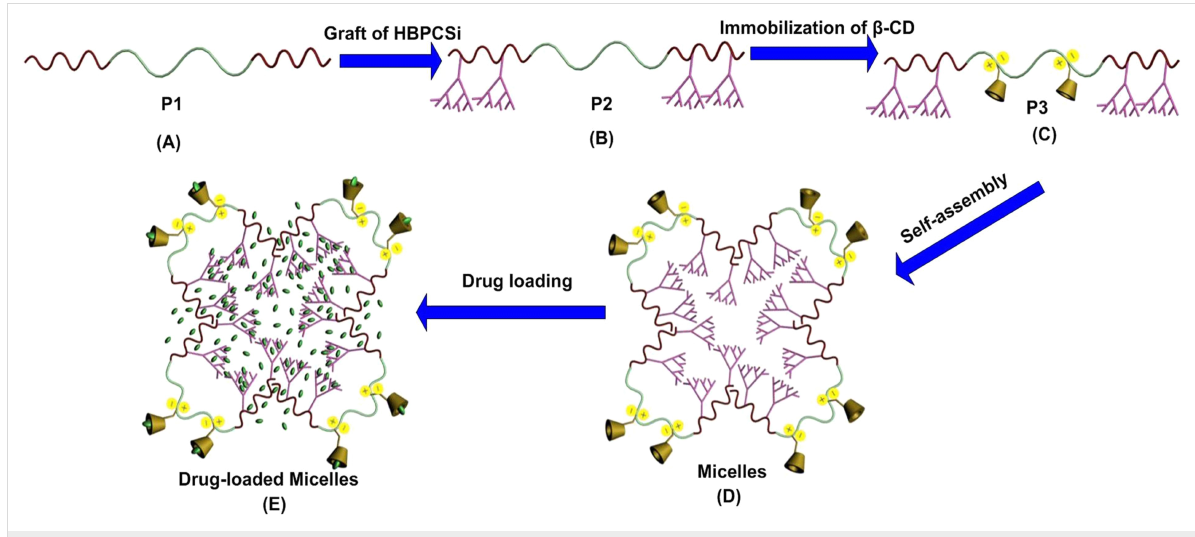
Scheme 1: Schematic representation of the details for the construction of a multifunctional nanocarrier used for drug